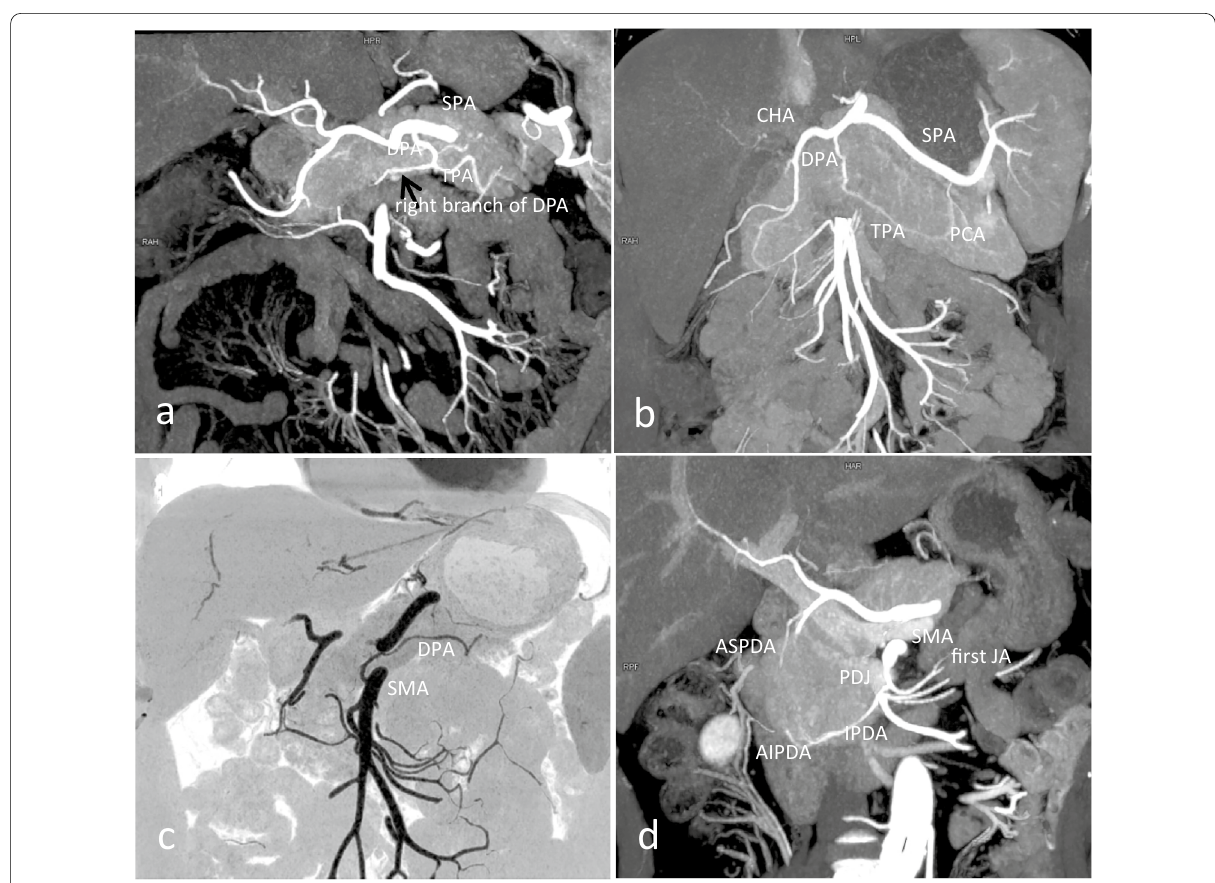
Fig. 5 The normal anatomy and variations in pancreatic supplying arteries. a MIP shows the dorsal pancreatic artery (DPA) originating from splenic artery (SPA), bifurcates into the right branch and the transverse pancreatic artery (TPA), which forms an inverted “T” pattern branching. b The DPA originates from the common hepatic artery (CHA), bifurcates into the TPA, and then anastomoses with caudal pancreatic artery (PCA). c Minimum intensity projection (MinIP) shows the DPA originating from the superior mesenteric artery (SMA). d MIP shows the inferior pancreaticoduodenal artery (IPDA) originating from the first jejunal artery (JA) to form the pancreatico‑duodeno‑jejunal (PDJ) trunk